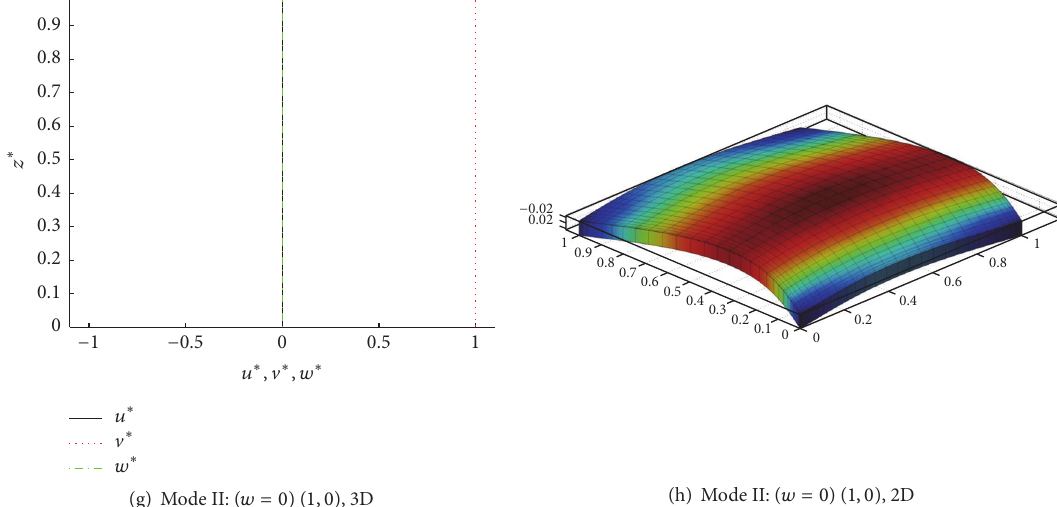
Figure 2: Differences between in-plane and cylindrical bending vibration modes for the 𝑎/ℎ = 20 one-layered FGM plate with 𝑝 = 0.5 . 3D modes versus 2D